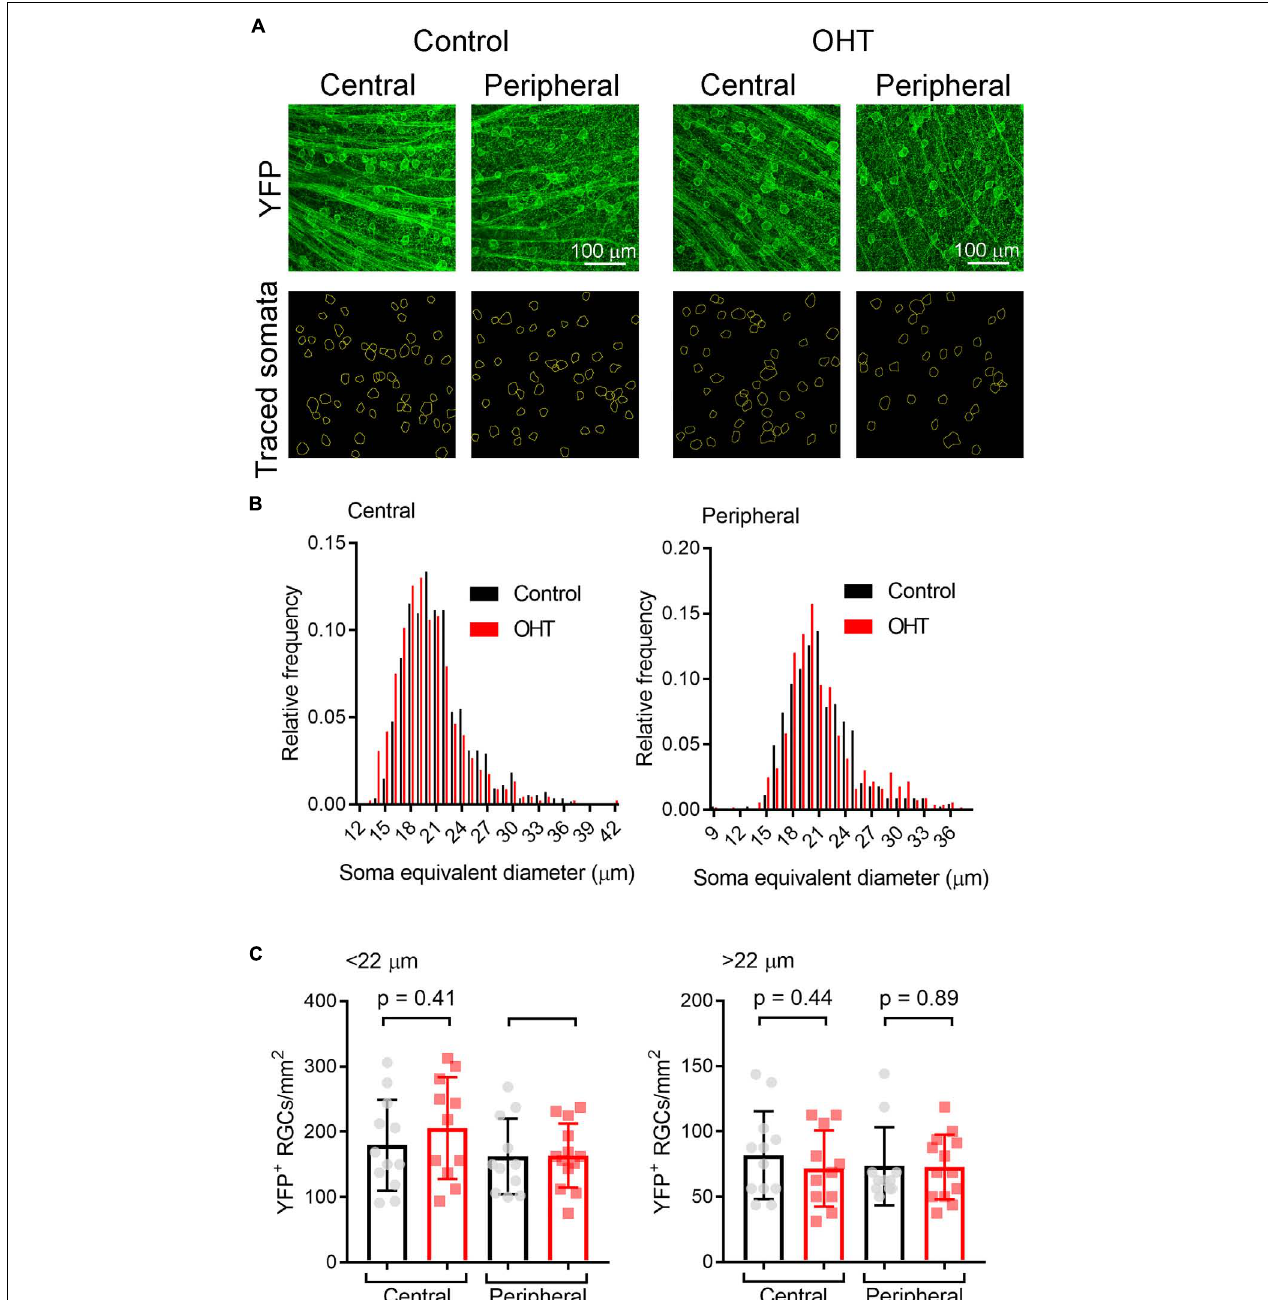
FIGURE 11 | Analysis of ChR2-YFP RGC density by soma size. (A) 2-photon images of retinas showing ChR2-YFP expression (enhanced with immunofluorescence staining with an anti-GFP antibody) in central and peripheral regions of ventral retinas. Lower panels show somatic regions of interest traced by hand in ImageJ. (B) Distribution of equivalent soma diameters of traced somata in central and peripheral retina from control and OHT eyes. (C) Measurements of RGC density for cells with somata with diameters < 22 µ m (left) and > 22 µ m (right). Data points of density for each image are shown and the bar graph represents mean + SD (central control, n = 12 retinas; peripheral control, n = 11 retinas; central OHT, n = 11 retinas; peripheral OHT, n = 13